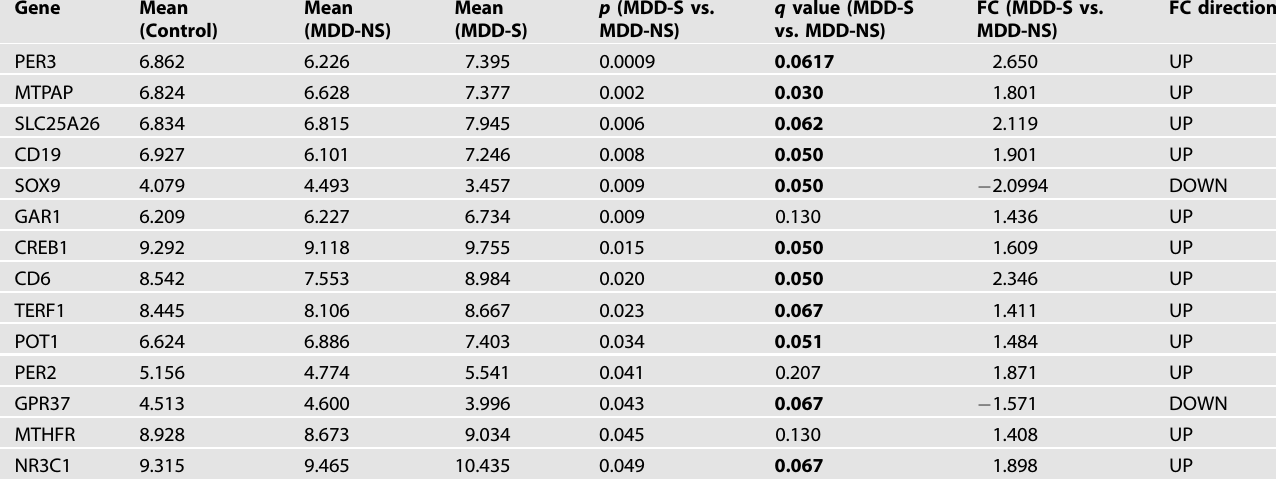
Table 2. Blood-based signi fi cantly differentially expressed genes ( p ≤ 0.05) between MDD-S and MDD-NS, the corresponding q value after FDR correction ( Q ≤ 0.1 are in bold), and fold change in MDD-S relative to